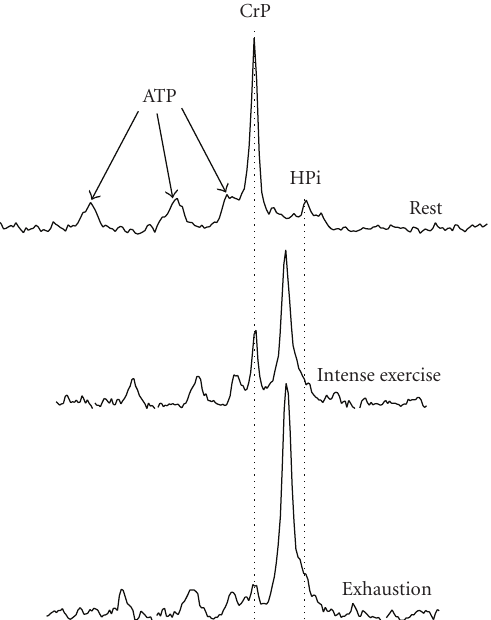
Figure 7: The 31 P MRS spectrum of resting muscle (top), muscle at near complete CrP depletion (middle), and muscle with complete CrP depletion (bottom). Note the decrease in CrP and increase in HPi as well as the resonance frequency shift of the HPi peak relative to CrP, indicating acidosis. The muscle pH of each condition is 7.01, 6.74, and 6.18, respectively. Based on unpublished research observations of the